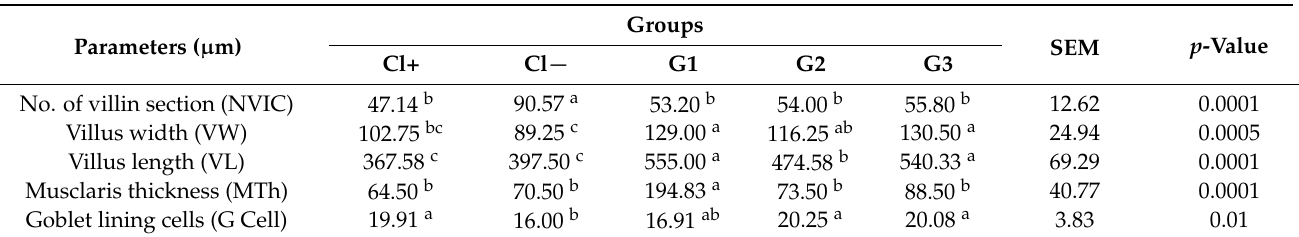
Table 8. Villus morphology and morphometry characterizations of rabbits as affected by yogurt containing 1% whey protein concentrate (G1), calcium caseinate (G2) and Spirulina powder (G3) compared to that of non-supplemented yogurt as a positive control (Cl+) or yogurt-free diet as a negative control (Cl − ).